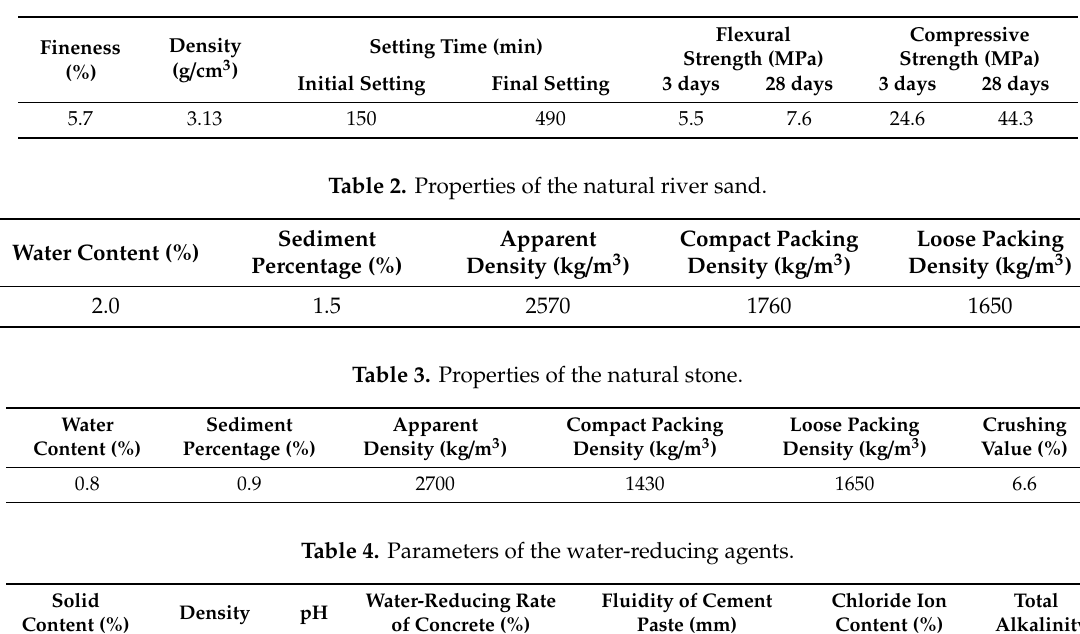
Table 1. Physical and mechanical properties of Portland cement.